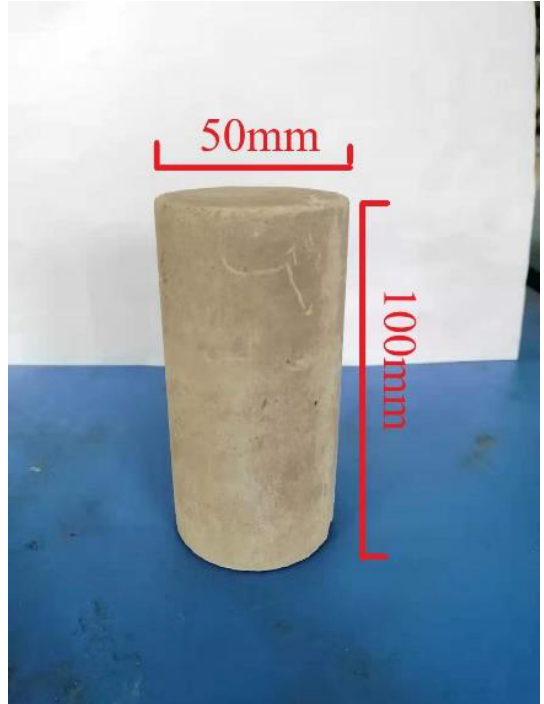
Figure 1. Sandstone specimens. Table 1. Physical and mechanical properties of sandstone.